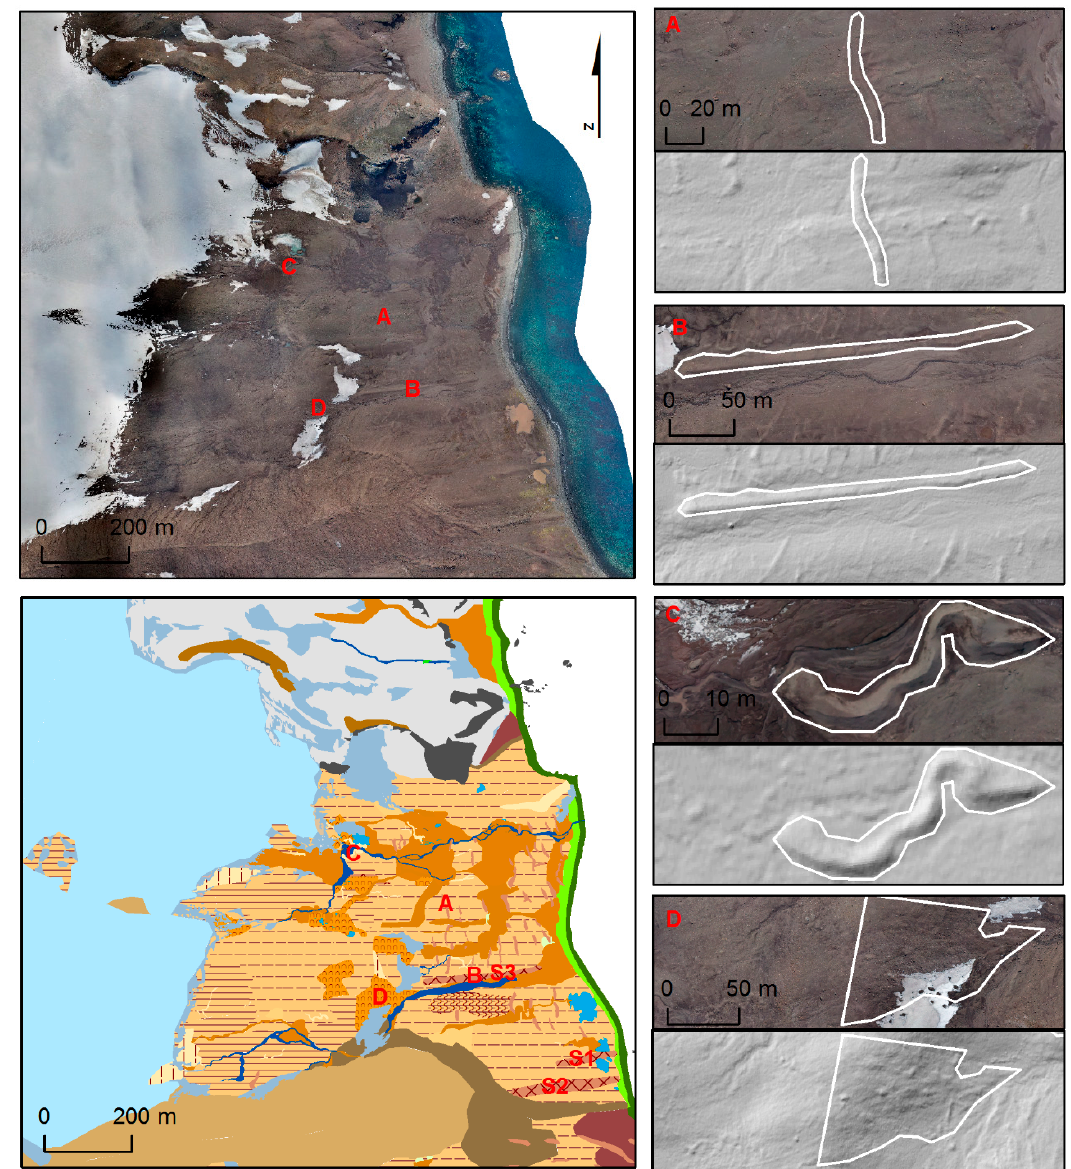
Figure 9. Sphinx Glacier foreland: an orthophoto and a detailed geomorphological map (see Figure 6 for legend), and examples of vectorized landform units (white polygons) based on the orthophoto and the Digital Elevation Model; A—large recessional moraine ridge; B—drumlin, C—esker, D—hummocky moraine; S1–S3 mark drumlins, which are discussed in Section 4.3, Figure 11, Table 2.